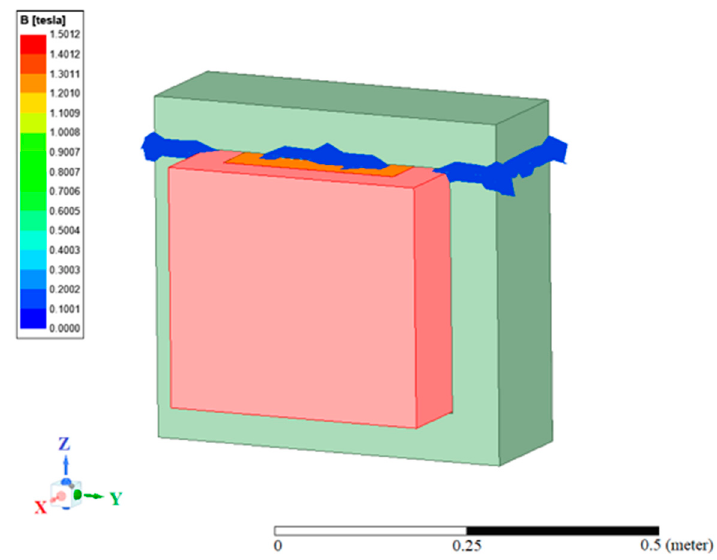
Figure 4. The spatial scattering magnitude of flux density leaking out from the air gaps around the transformer core.